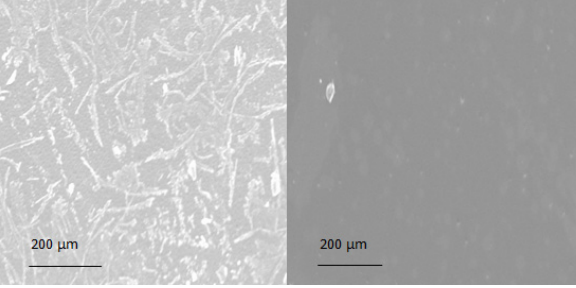
Figure 5. SEM surface images of drug loaded ( left : D) and drug-free ( right : P) formulation (batch codes according to Table